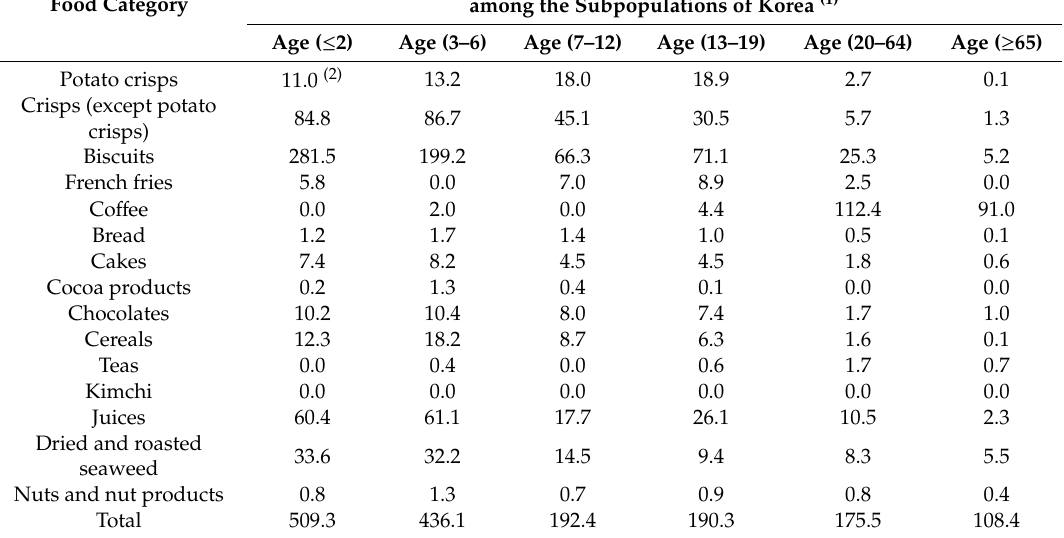
Table 4. Dietary exposure to acrylamide among the subpopulations of Korean based on the 95th percentile values of dietary